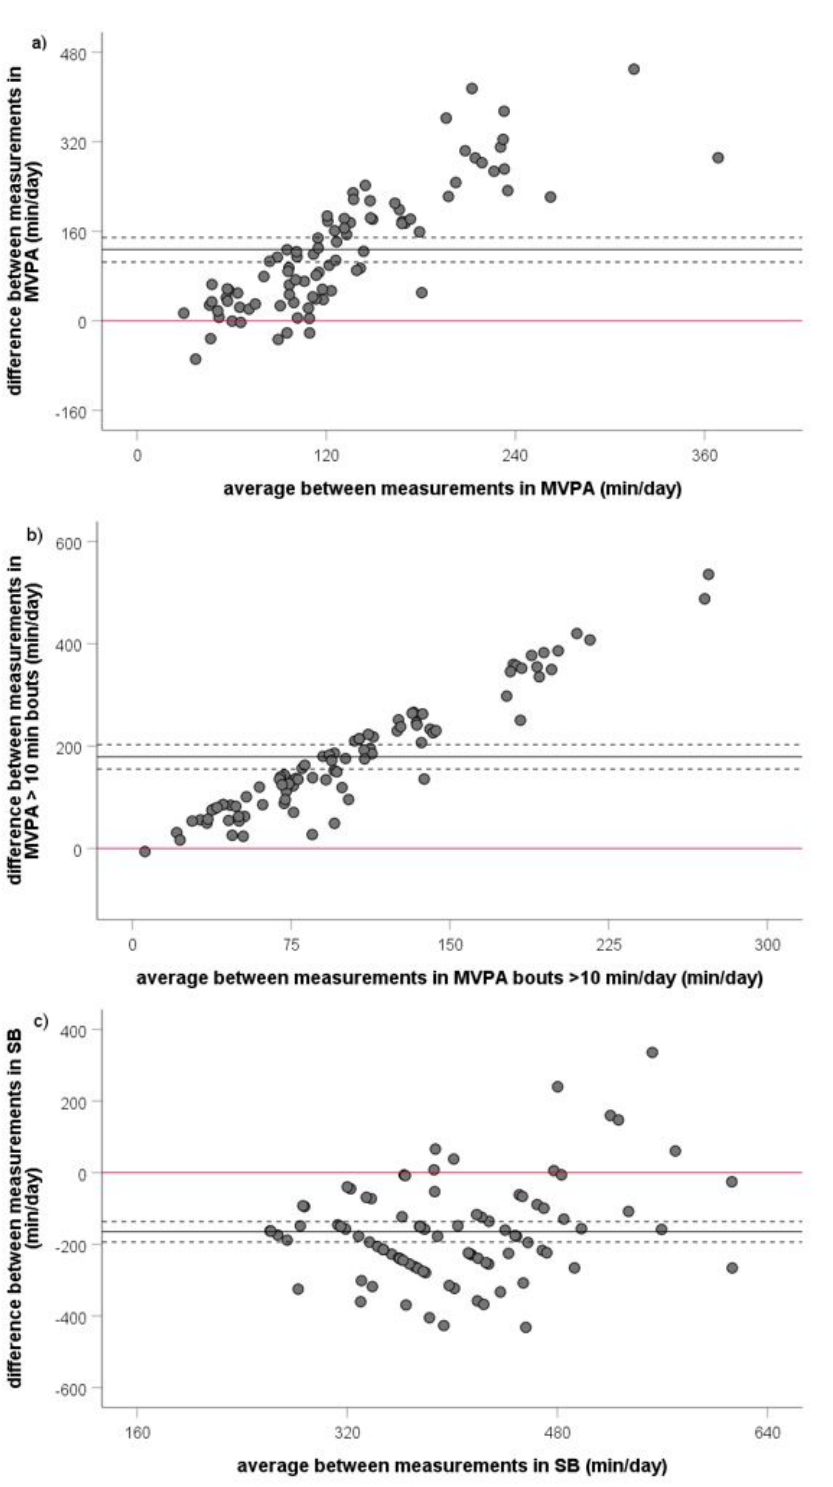
Figure 4. Qualitative analysis of proportional bias between objective and subjective assessment of MVPA ( a ), MVPA > 10 min bouts ( b ), and SB ( c ) using Bland–Altman plots. MVPA—moderate to vigorous physical activity; SB—sedentary behavior. Bold lines present mean value of the difference between both measures (difference = IPAQ-SF − accelerometry), dotted lines present lower and upper bound of 95% confidence interval of the difference between measures, and red bold line presents